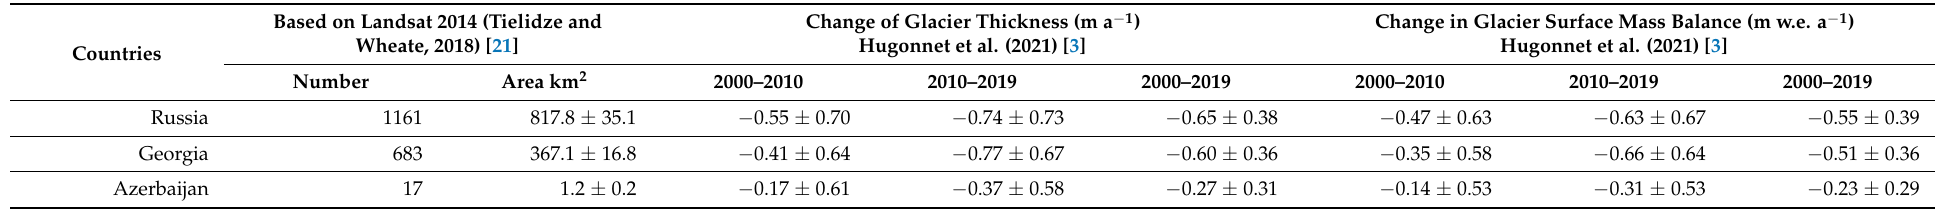
Table A2. Change in glacier thickness (m a − 1 ) and surface mass balance (m w.e. a − 1 ) for Caucasus countries (Russia, Georgia, Azerbaijan) in 2000–2010, 2010–2019, and 2000–2019.